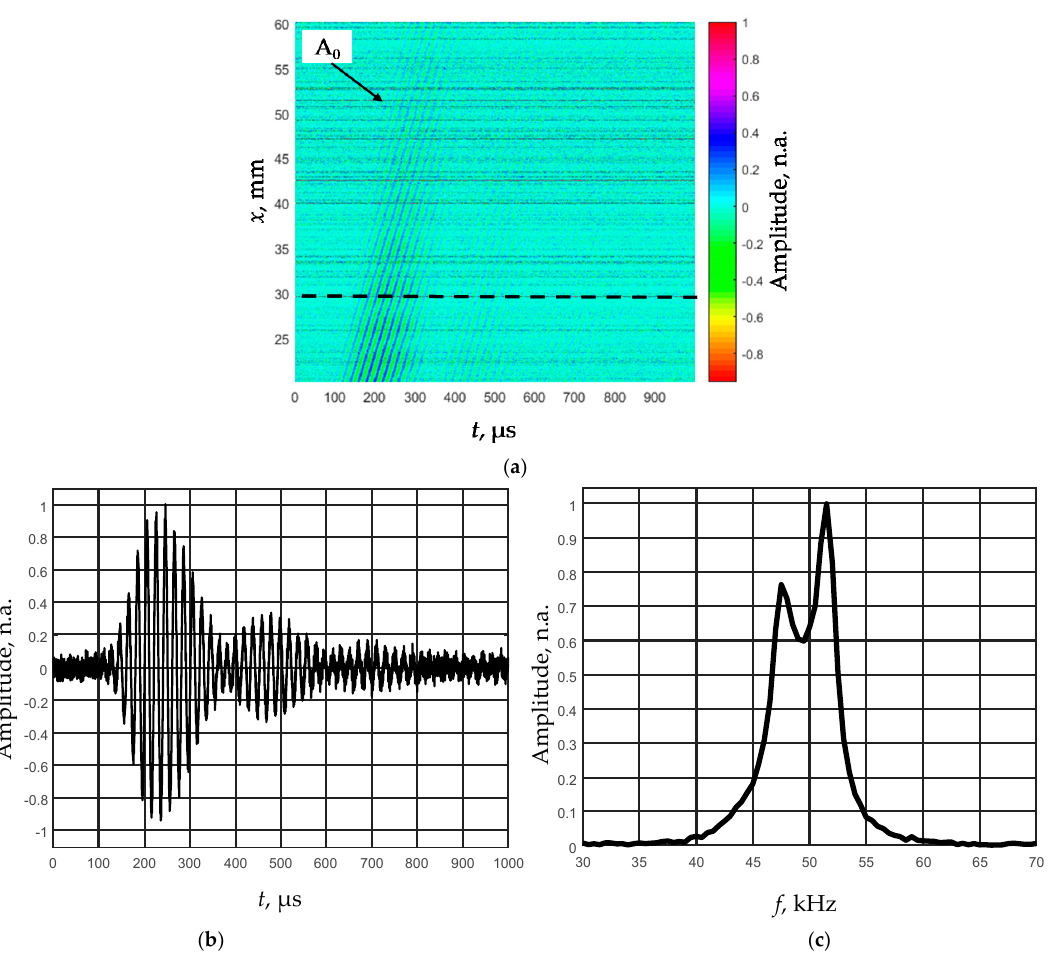
Figure 9. Air-coupled excitation of the A 0 mode at the low frequency (50 kHz) in 150 µm thickness PVC film: the measured B-scan image of the normal displacements ( a ), the recorded signal at the distance 30 mm from the transmitter ( b ), and the spectrum of this signal ( c ).